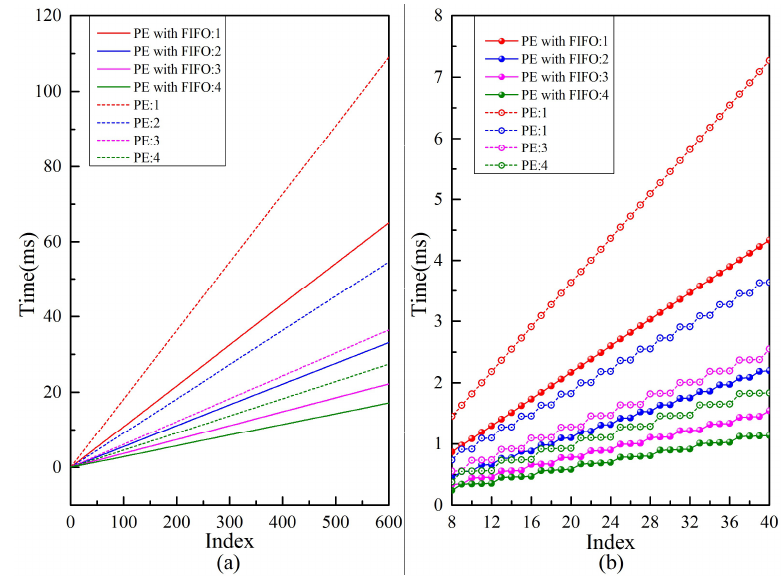
Figure 11. Time consumption graphs of PE and optimized PE: ( a ) time consumption of processing 600 sets; ( b ) partially enlarged view time consumption of processing 600 sets.